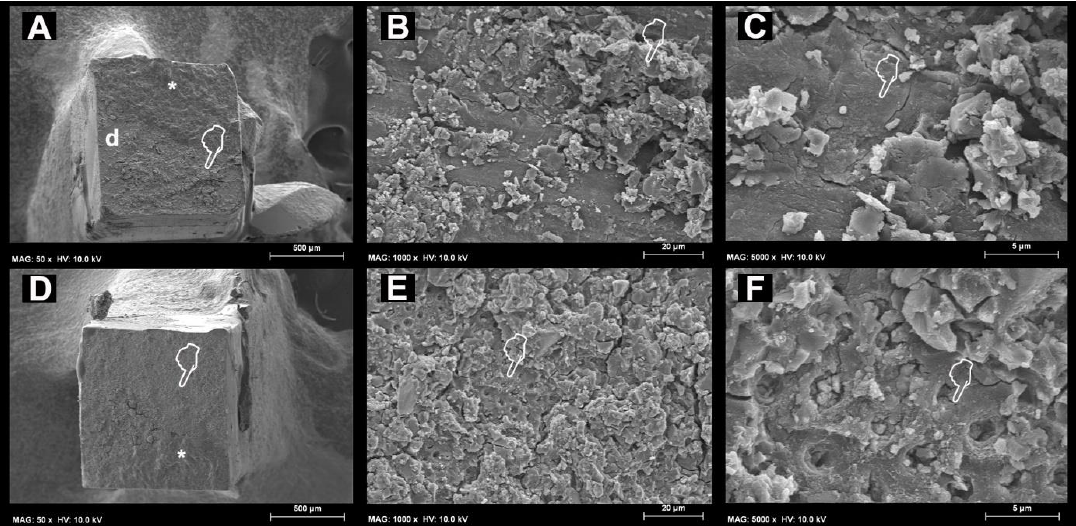
Figure 2. SEM micrographs obtained after load cycle followed by prolonged AS storage. ( A